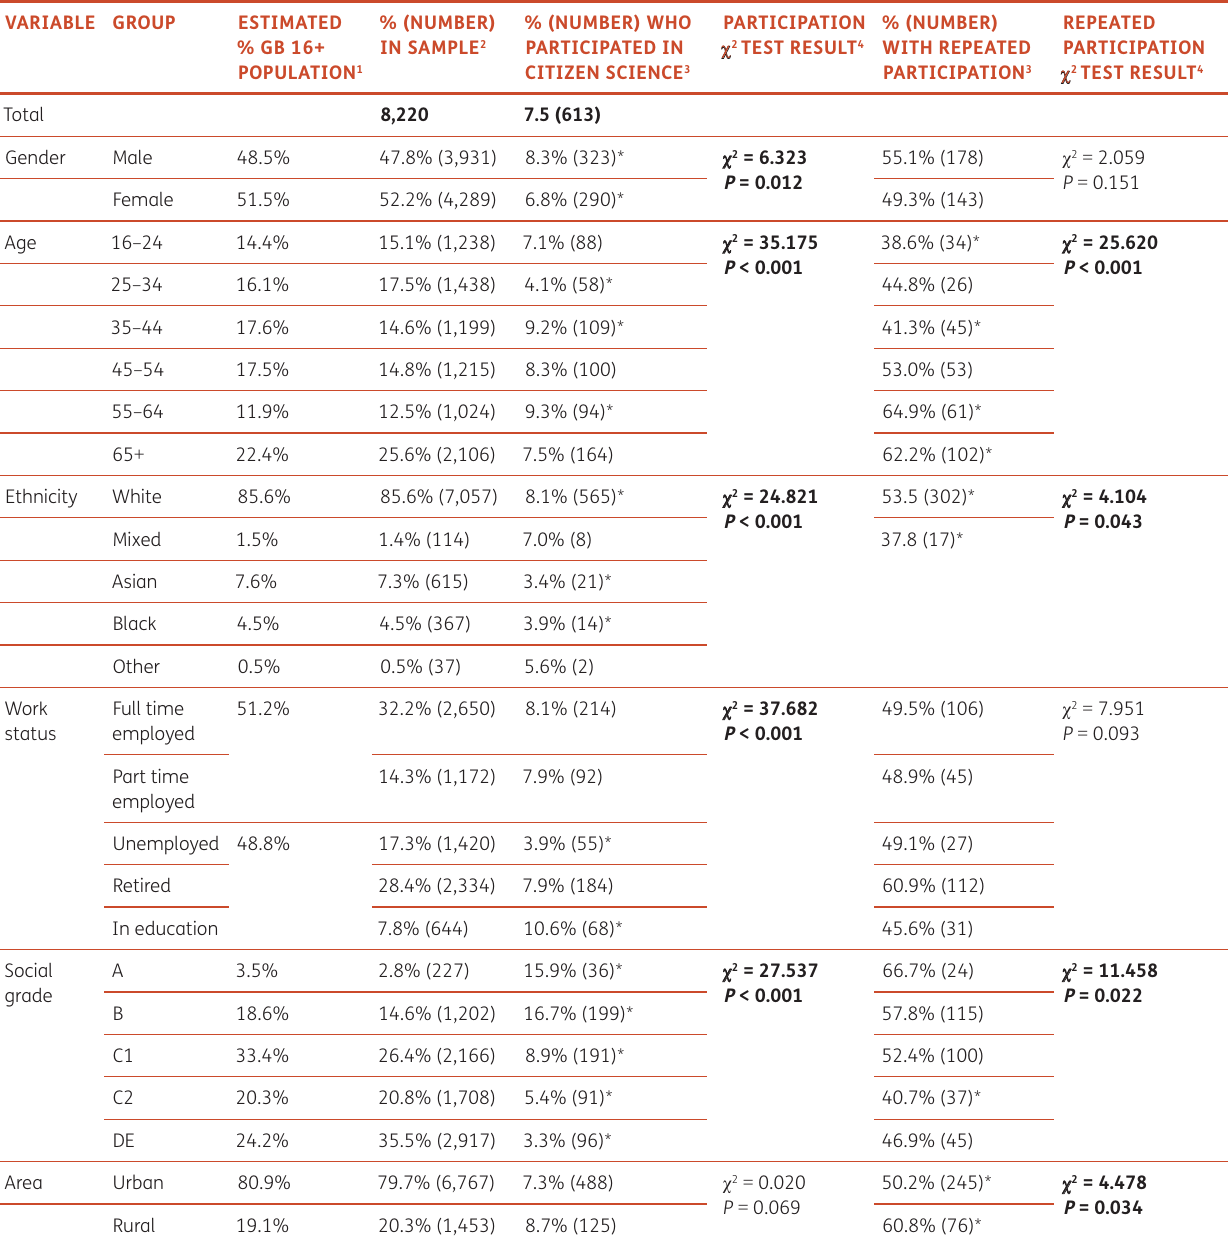
Table 1 Participation in citizen science by demographic